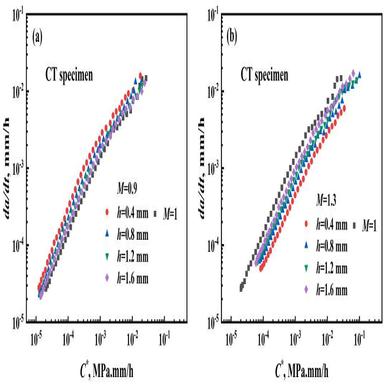
The da/dt-C\ curves for CT specimens under different weld widths at mismatch factor of (a) M = 0.9 and (b) M = 1.3.